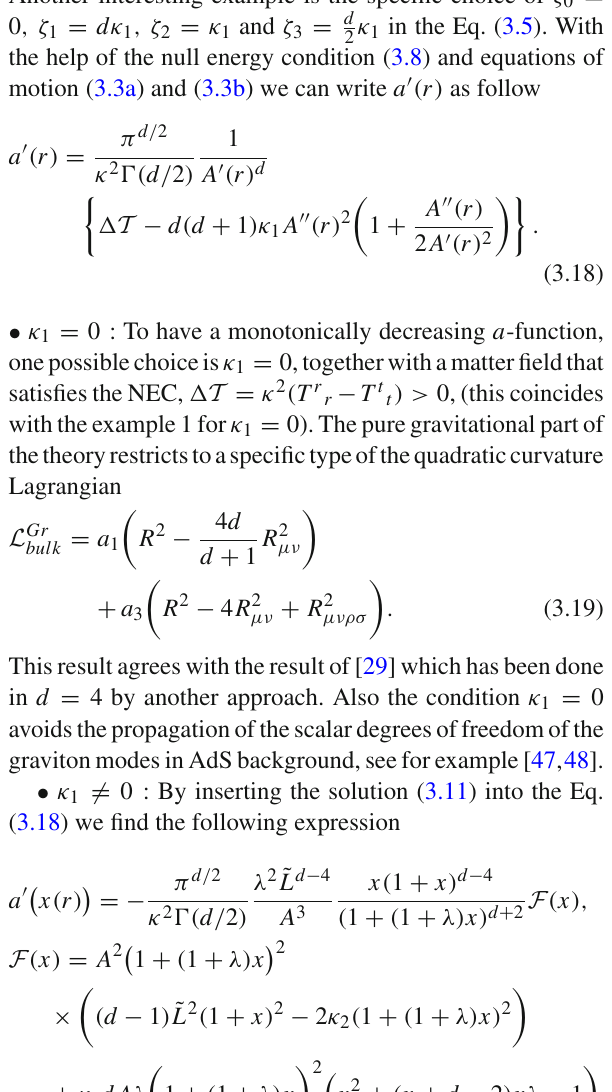
Fig. 4 Monotonicity, NEC and ANEC regions. This graph is depicted for special values, d = 4, A = ± 0 . 1, B = − 2 and ˜ L = 1 . 2, but for every value of these parameters in the allowed regions we always observe the same